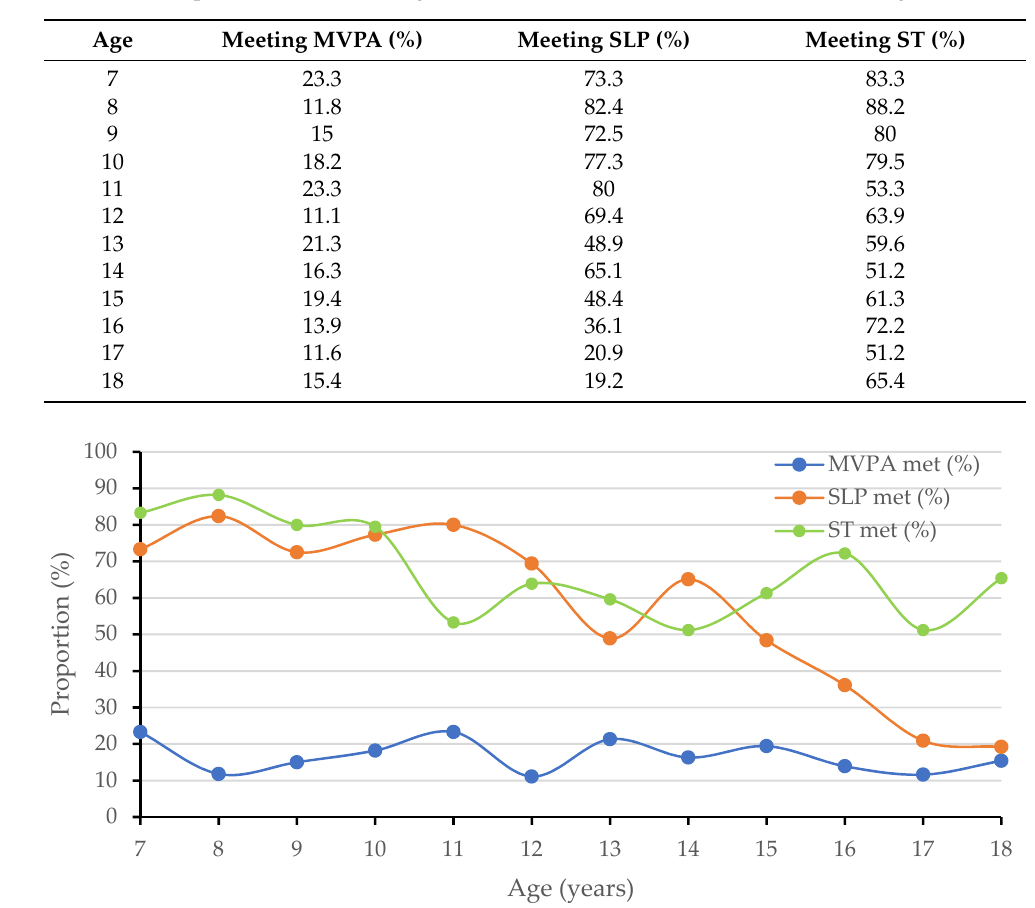
Table A2. Compliance rates for three guidelines in Chinese children and adolescents aged 7–18.